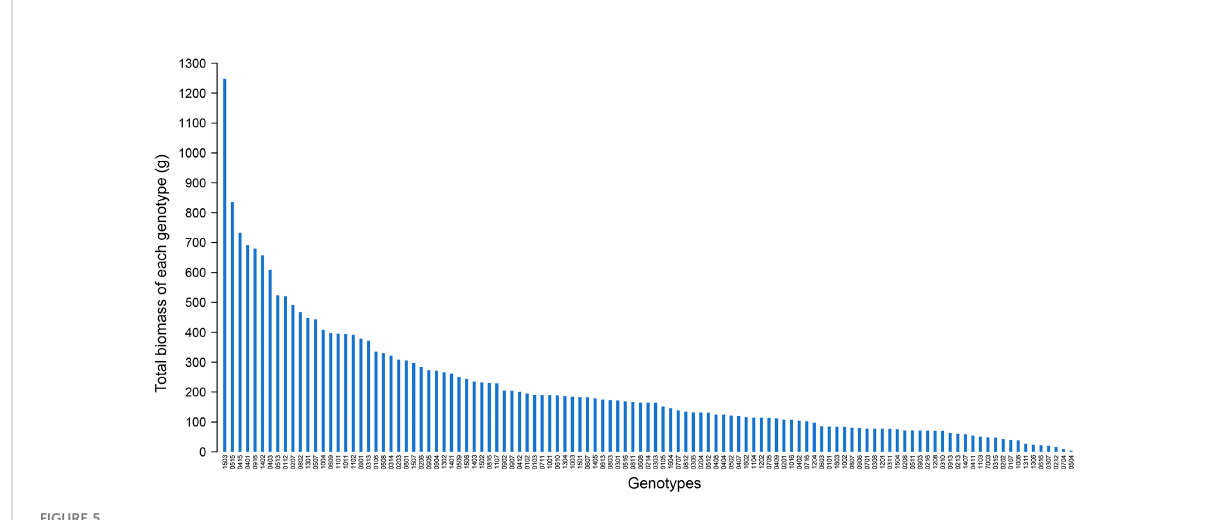
FIGURE 5 The distribution of the total biomass of all survival ones from 10 individuals planted in 10 m 2 for each hybrid genotype in November